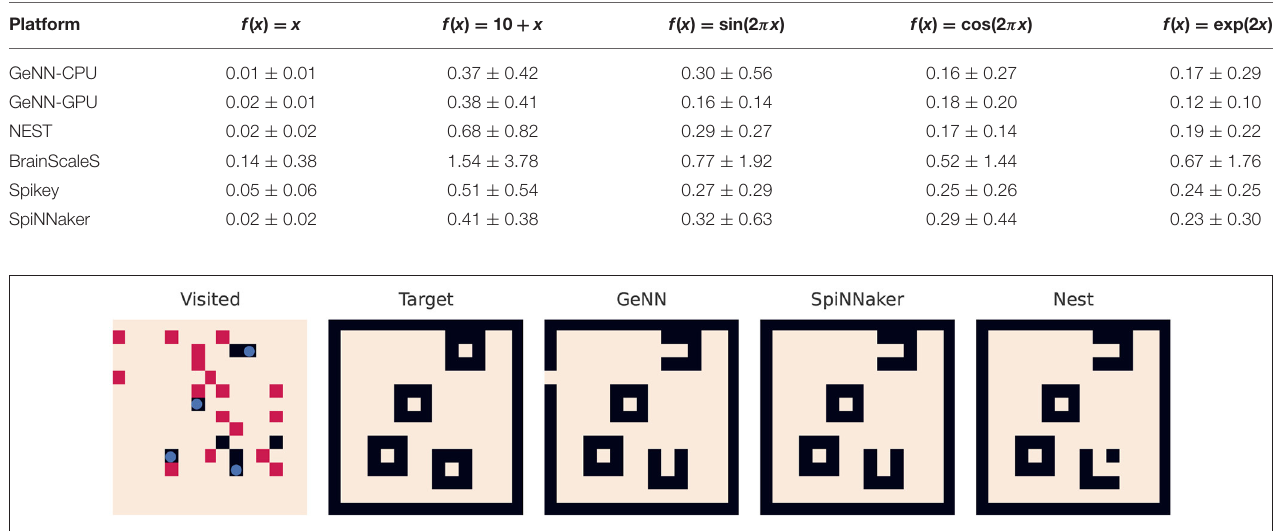
FIGURE 7 | Result of the spiking SLAM benchmark. The leftmost map visualizes the map with the obstacles (blue circles). Black pixels are not visited by the virtual agent while red ones are visited once or twice. The best achievable representation is missing two pixels (see the SpiNNaker result), as two points close to the right obstacles are not visited by the virtual agent.